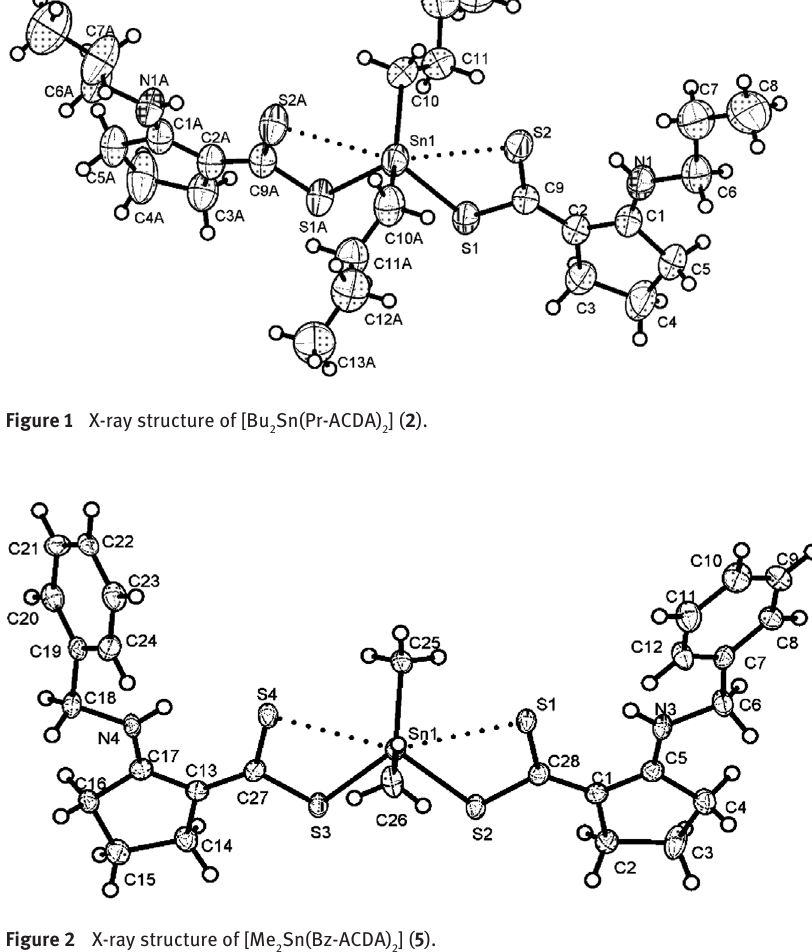
Figure 2 X-ray structure of [Me